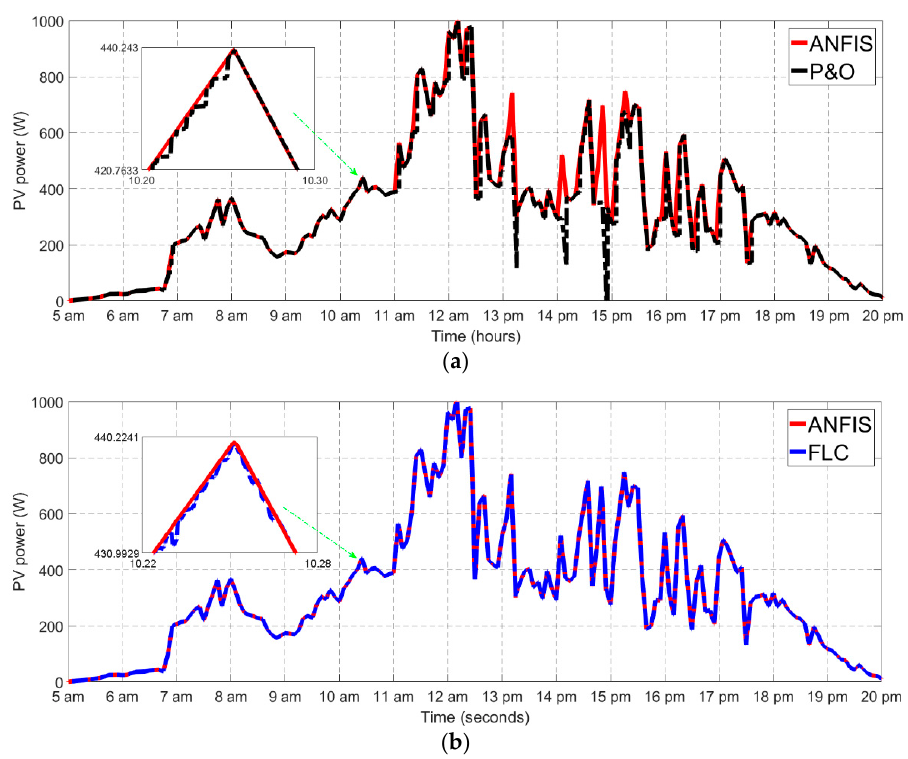
Figure 12. ( a ) Real measurement test of one day of: ( a ) Solar irradiance and ( b ) operating temperature.